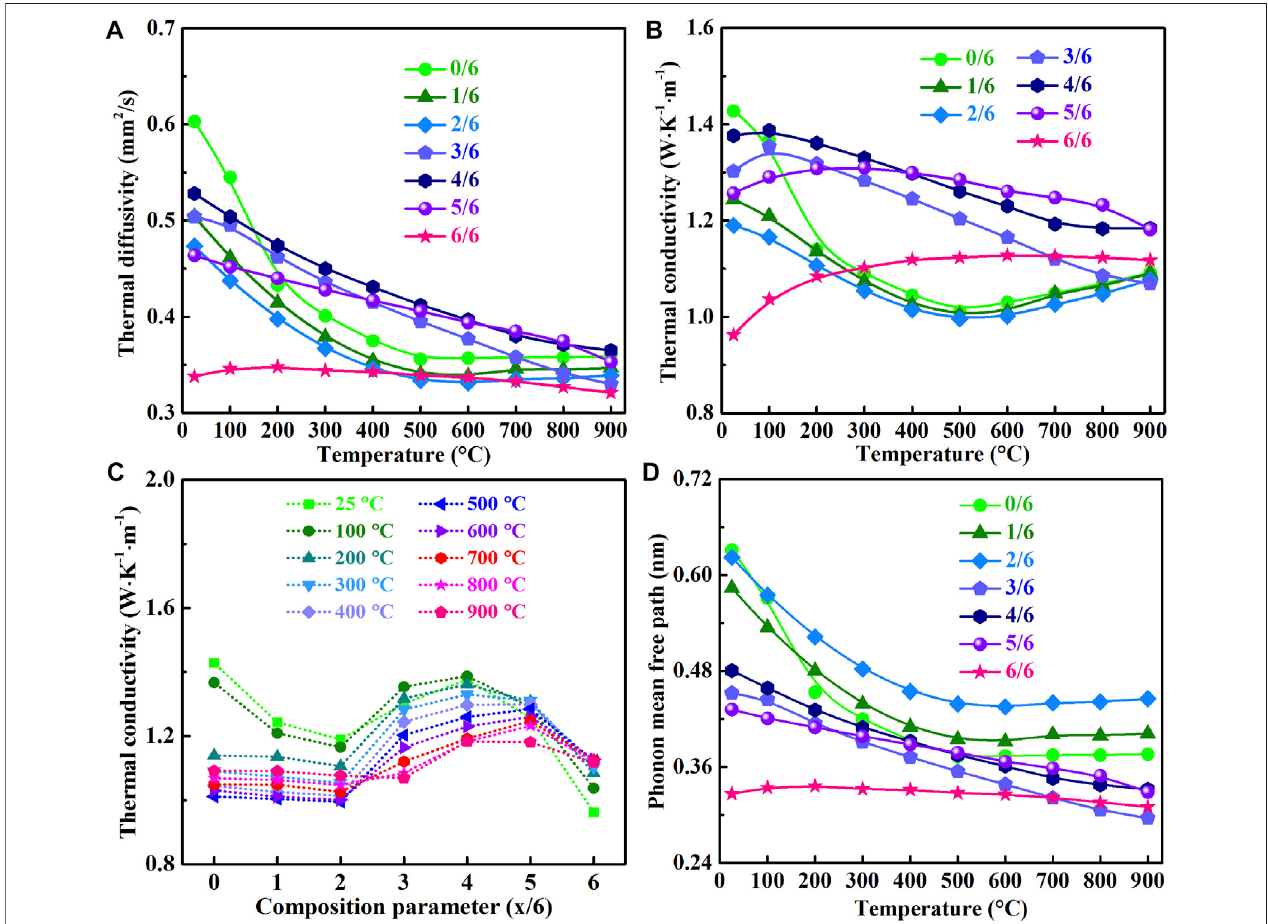
FIGURE 5 | Thermal properties of (La 1-x Ho x ) 3 NbO 7 ( x (cid:2) 0/6, 1/6, 2/6, 3/6, 4/6, 5/6, and 6/6) ceramics: (A) thermal diffusivity, (B) temperature dependence of thermal conductivity, (C) composition dependence of thermal conductivity, and (D) phonon mean free path.